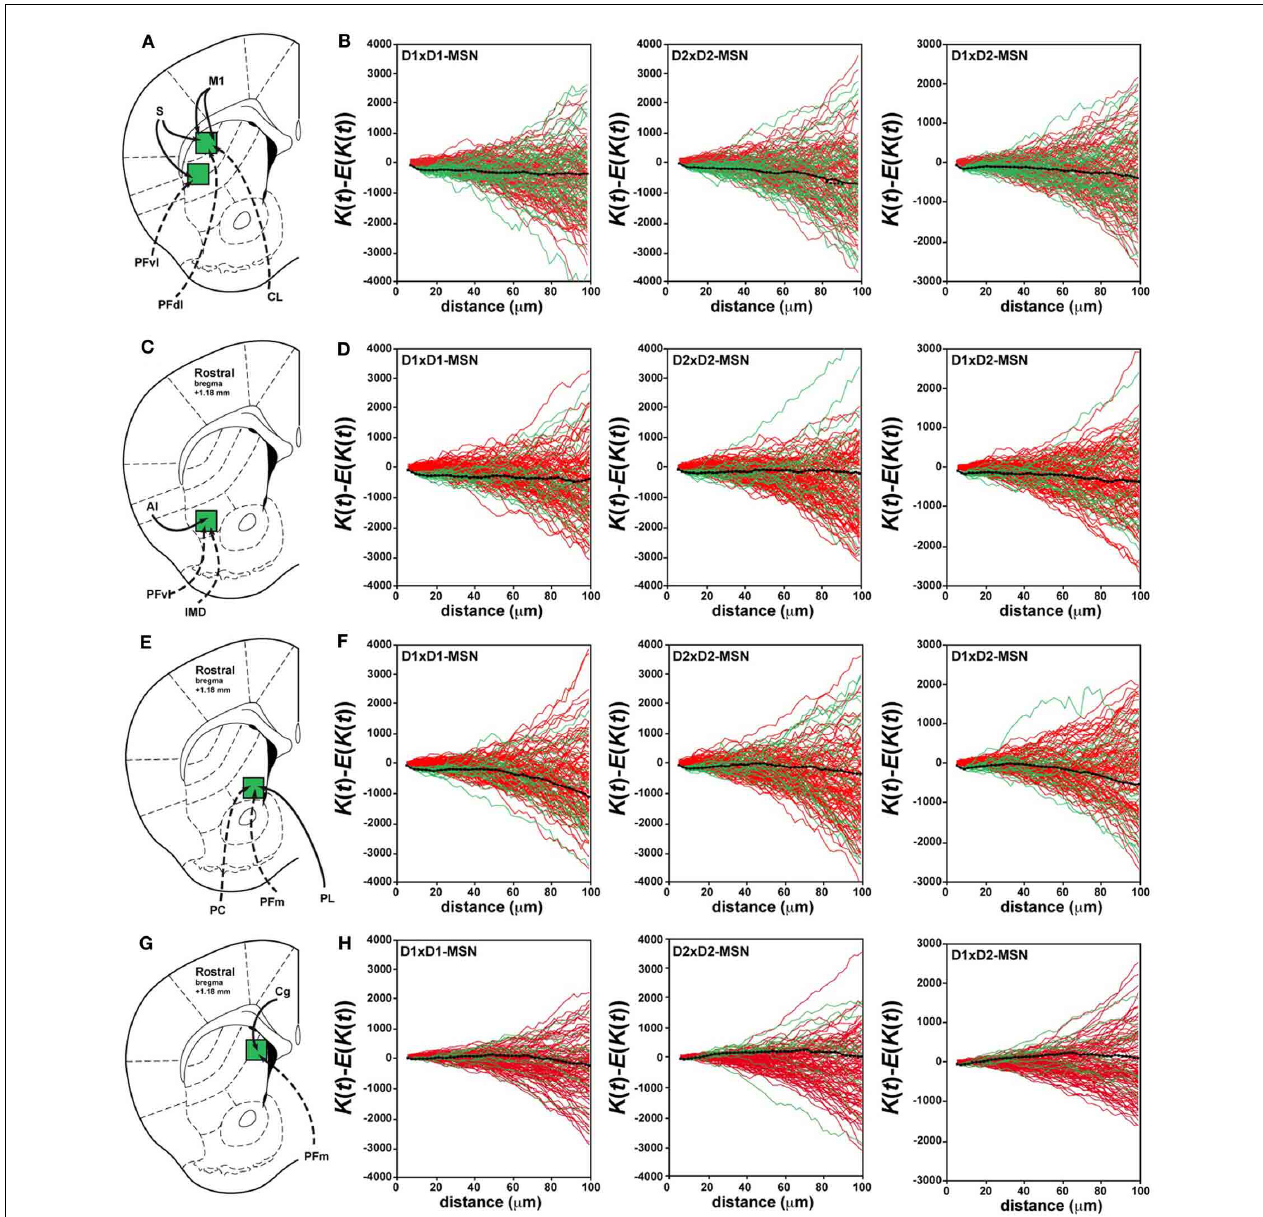
FIGURE 2 | Random distribution of D1R- and D2R-expressing MSNs in the rostral part of the dorsal striatum. (A,C,E,G) Schematic illustration of the different striatal sectors analyzed at the rostral level with their corticostriatal (solid lines) and thalamostriatal (dotted lines) connections. (A) Striatal sectors receiving cortical inputs from M1 (motor cortex) and S (somatosensory cortex) and thalamic inputs from PFdl (dorsolateral parafascicular nucleus), PFvl (ventral lateral parafascicular nucleus) and CL (centrolateral nucleus). (C) Striatal sector connected preferentially by AI (agranular insular cortex), PFvl (ventral lateral parafascicular nucleus) and IMD (intermediodorsal nucleus). (E) Striatal sector connected by PL (prelimbic cortex), PFm (medial parafascicular nucleus) and PC (paracentral nucleus). (G) Striatal sector connected